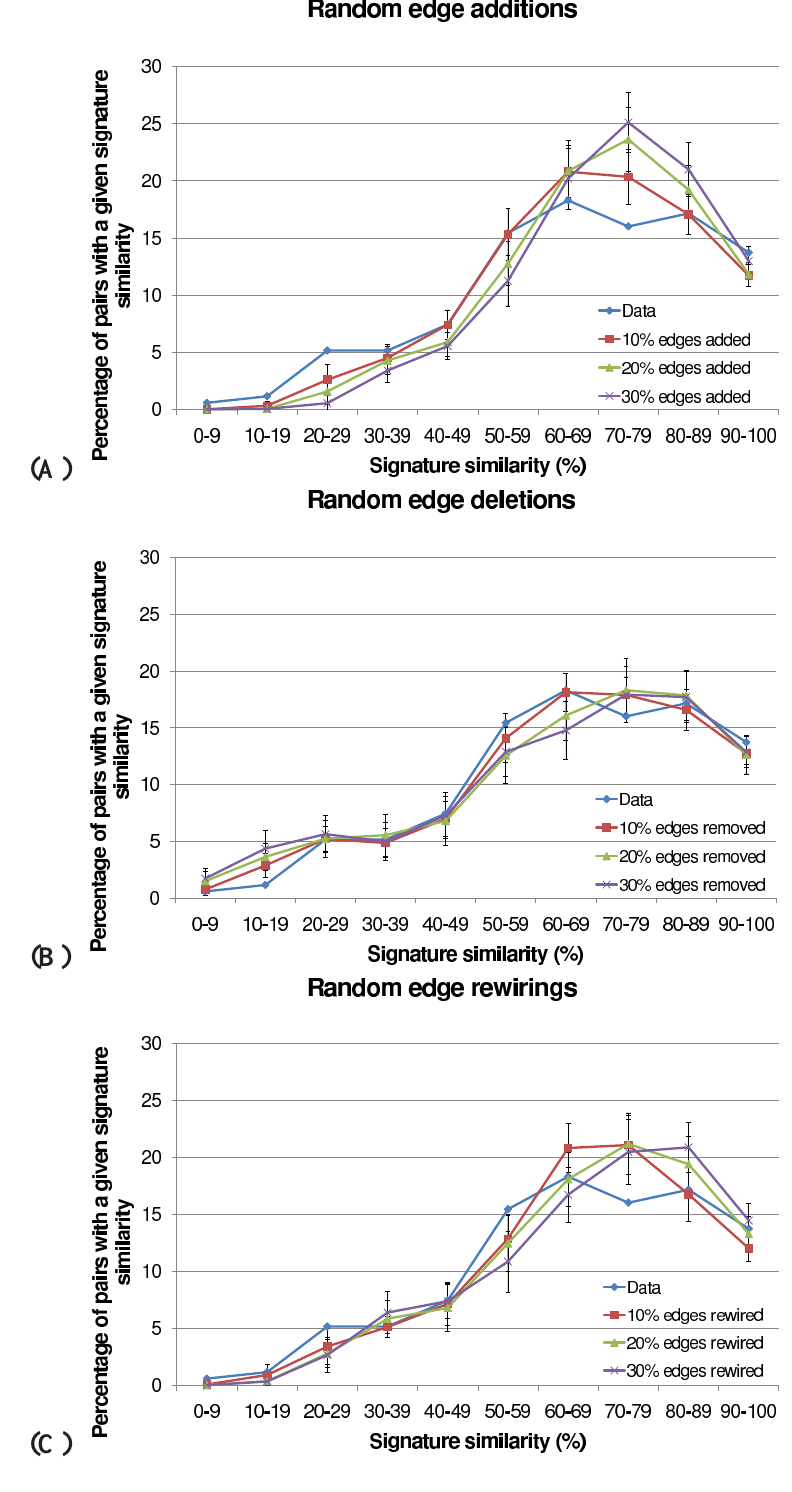
Figure S2: Comparison of signature similarity distribution of 175 orthologous protein pairs in the network (blue) and their signature similarity distributions computed from randomized networks, obtained by randomly (A) adding, (B) deleting, and (C) rewiring 10% (red), 20% (green), and 30% (purple) of edges in the PPI